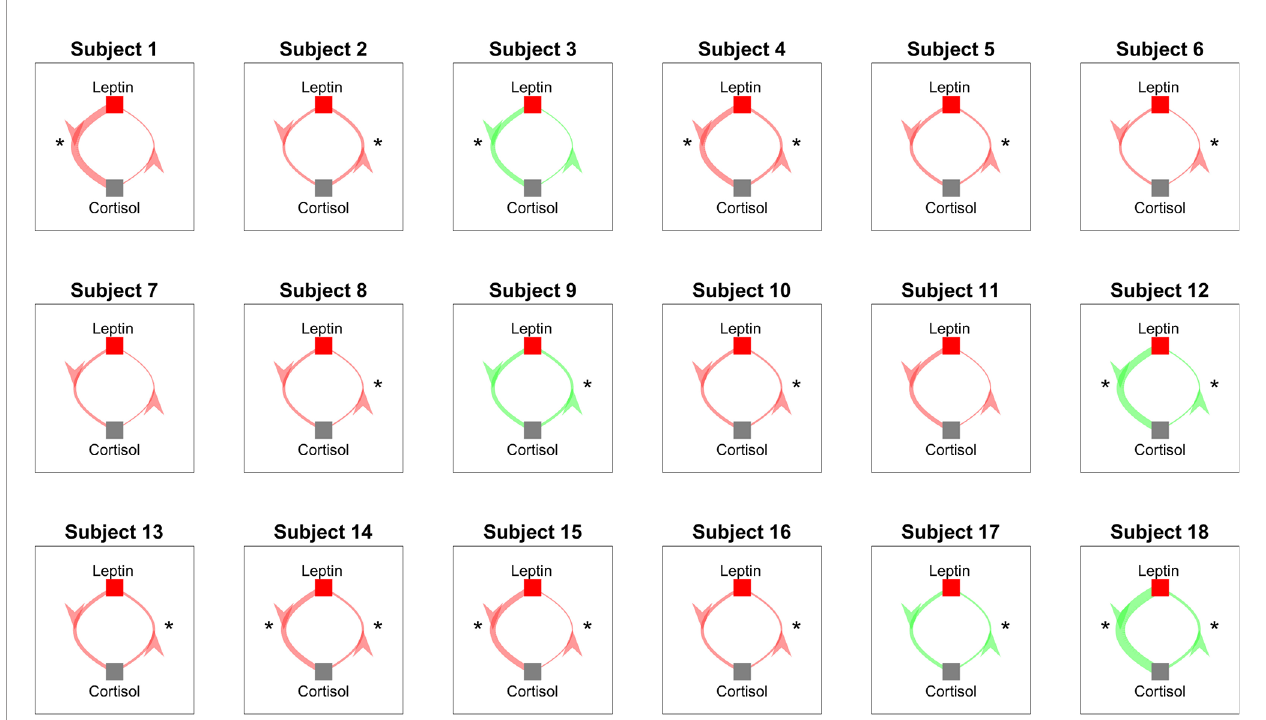
FIGURE 6 | Granger Causality Map Estimated for Leptin and Cortisol for 18 Women with Obesity. Red color shows a negative causal in fl uence and green color shows a positive causal in fl uence, respectively. The direction of each arrow indicates that the variable at the start of the arrow is causing the variable at the end of the arrow. The thickness of the arrows represent the magnitude of the interaction. Starts next to the arrows denote that the corresponding prospective predictions are statistically signi fi cant with p < 0.05. * denotes statistical signi fi